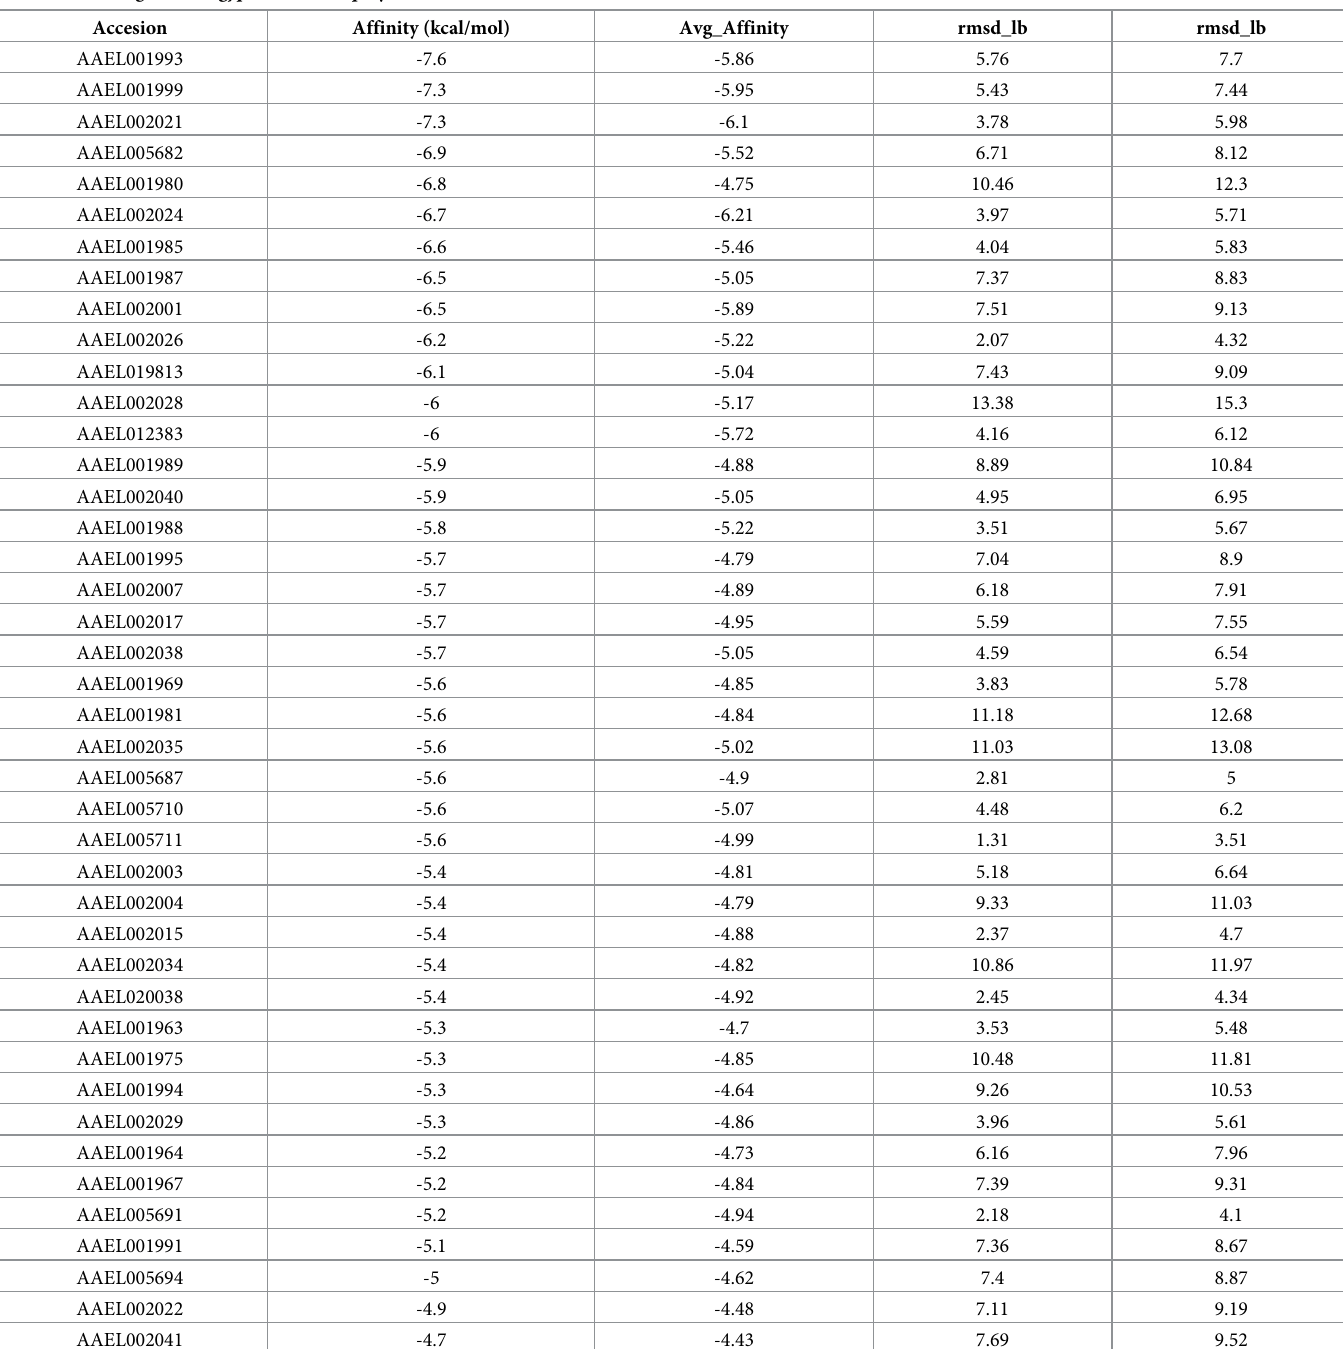
Table 1. Docking of Ae . aegypti CSPs with p